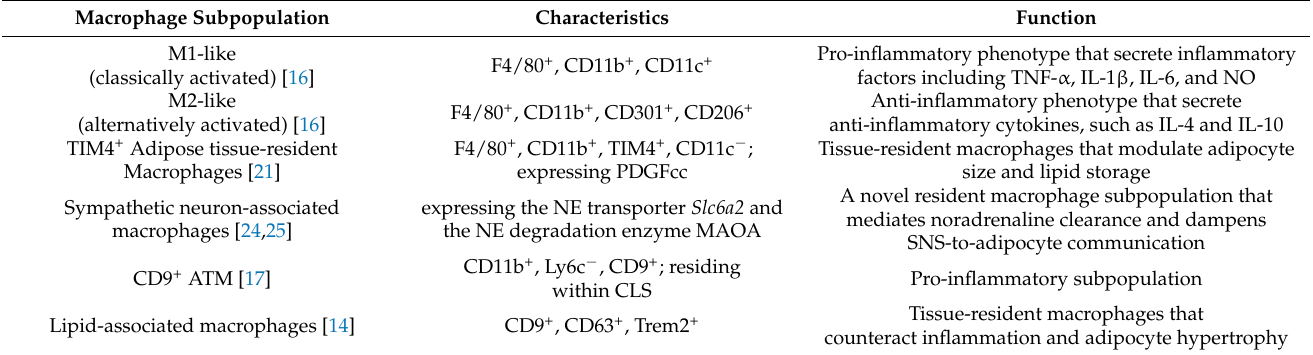
Table 1. Adipose tissue macrophage (ATM)